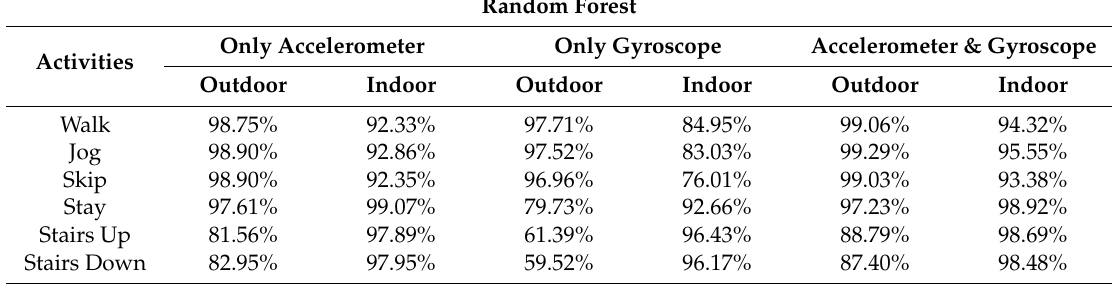
Table 6. The Overall F-score rates of user IO status due to different types of daily activity. Random